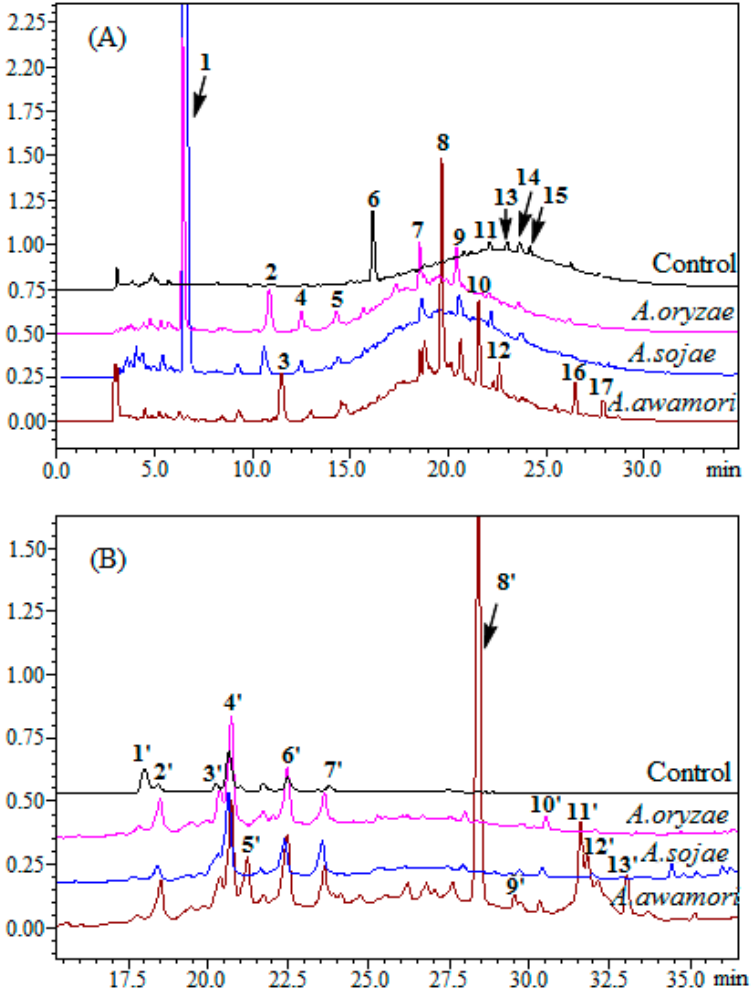
Figure 2. HPLC profile of hydrophilic ( A ) and hydrophobic ( B ) fractions of litchi pericarp from A. oryzae , A. sojae and A. awamori treatments.